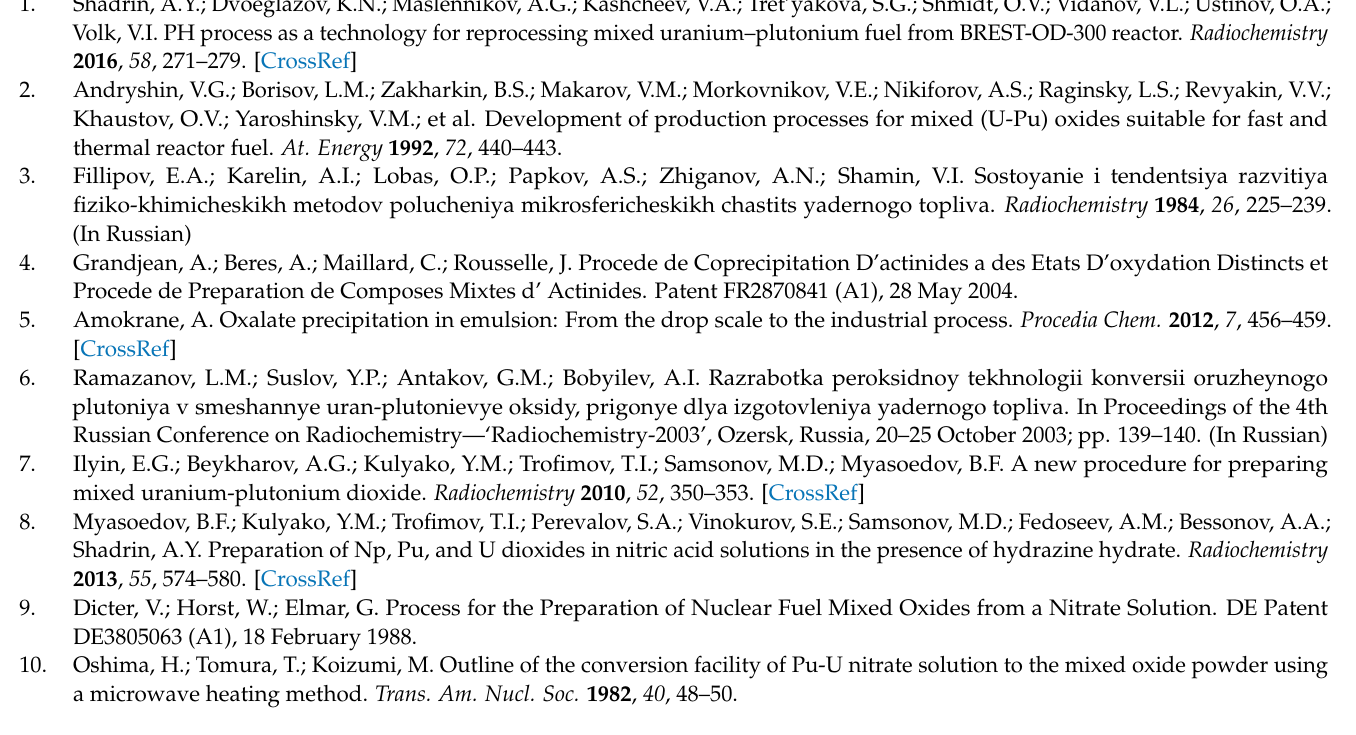
Figure S2: SEM images of the (U,Ce)O 2 powders obtained by microwave radiation with power of 800 W ( a ) and 180 W ( b